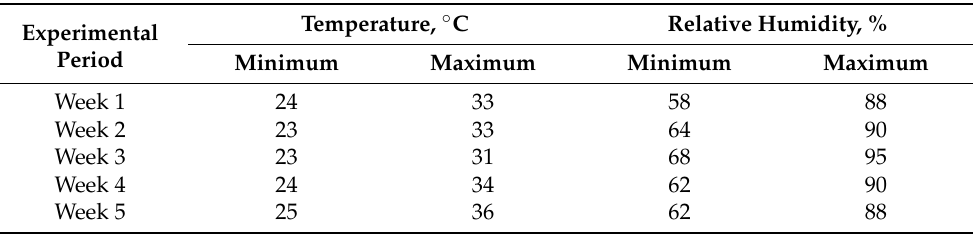
Table 1. Profile of environmental temperature and humidity during the experimental period. Temperature, ◦ C Relative Humidity, % Experimental Period Minimum Maximum Minimum